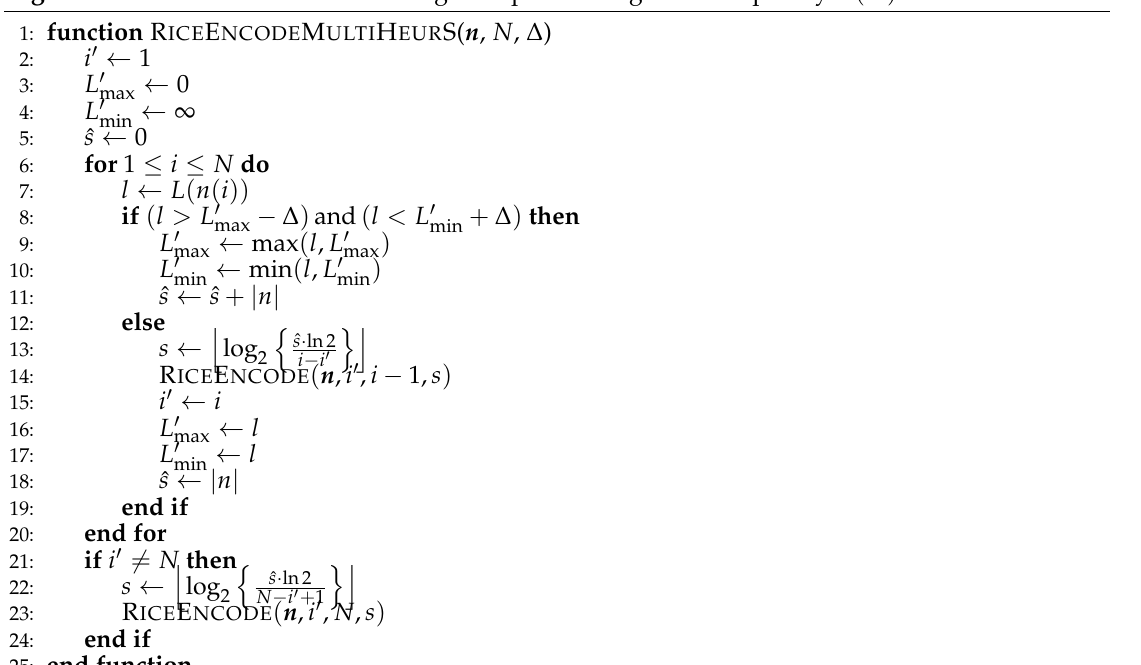
Algorithm 4 Heuristic for Rice encoding with partitioning with complexity O ( N )